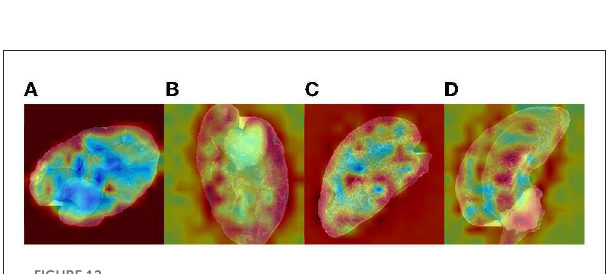
FIGURE12 The heat map of the features learned by DEEPMAE.